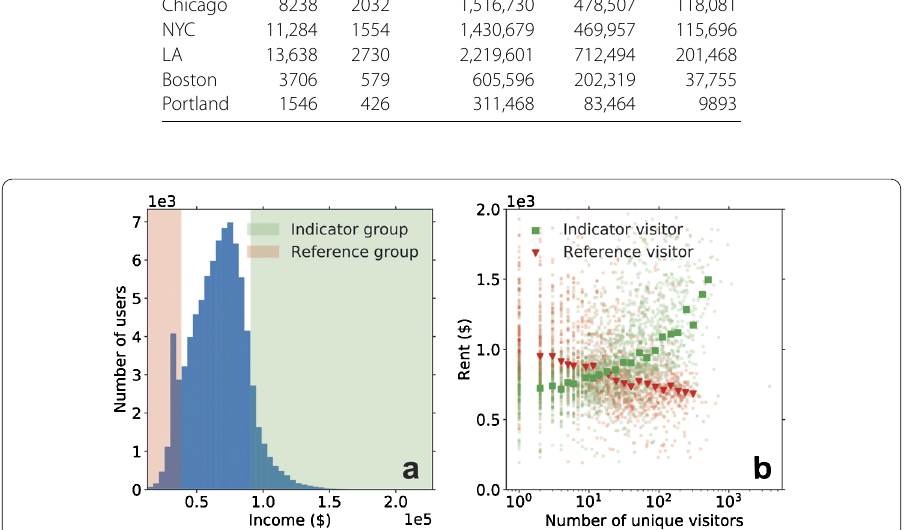
Figure 2 Selecting an indicator group. ( a ) Income-profile distribution for users in Chicago. We assign an income profile to each user based on the census median income of the visited neighborhoods. The 10 percent ‘richest’ users represent the indicator group (green) while the 10 percent ‘poorest’ users function as a reference group (red). ( b ) For each neighborhood, we compare the number of unique indicator visitors (green) and the number of unique reference visitors (red) in 2012/2013 with the neighborhood’s median rent prices in 2012. Neighborhoods that bring together more indicator visitors show higher rent prices while more reference visitors indicate lower rent